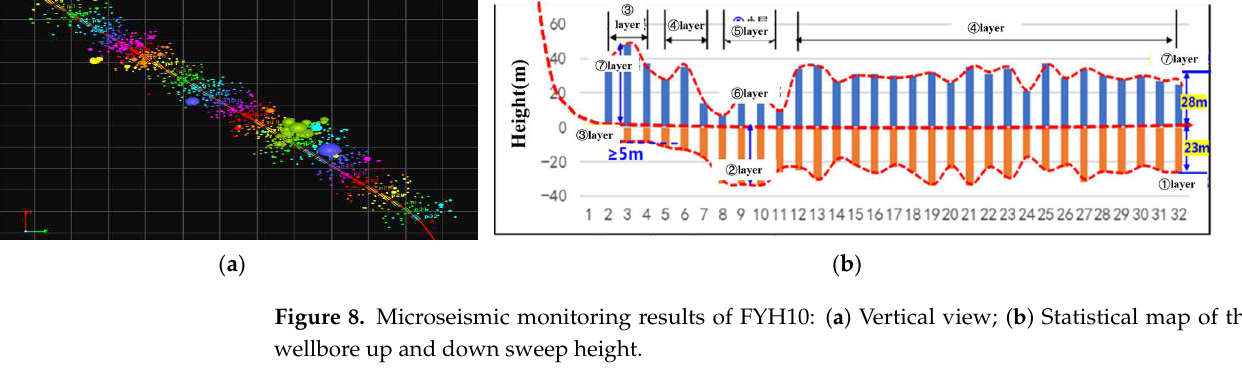
Figure 8. Microseismic monitoring results of FYH10: ( a ) Vertical view; ( b ) Statistical map of the wellbore up and down sweep height.